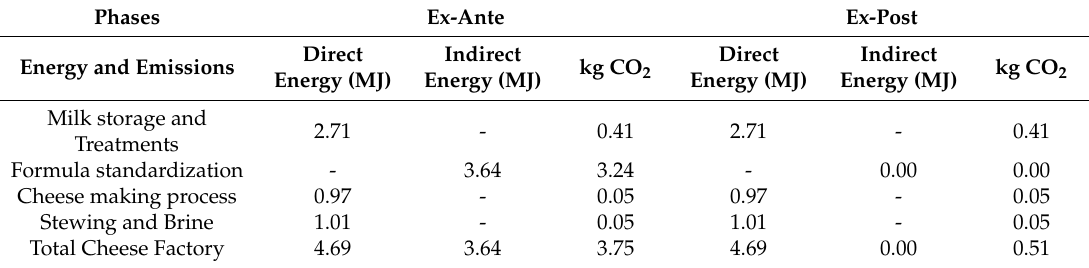
Table 3. Direct and indirect energy and carbon dioxide emissions summary, in the ex-ante and ex-post phase, reported for each main process carried out in the cheese factory and expressed per 100 kg of